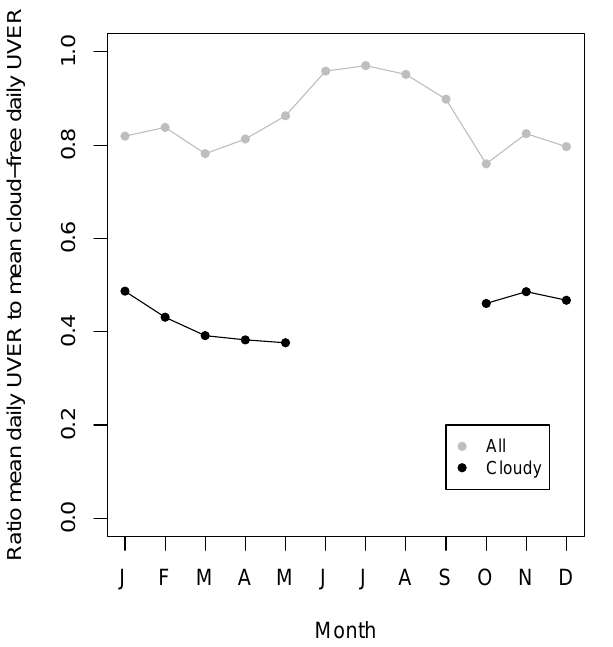
Fig. 5. Ratio mean daily ultraviolet erythemal irradiation to mean cloud-free daily ultraviolet erythemal irradiation.